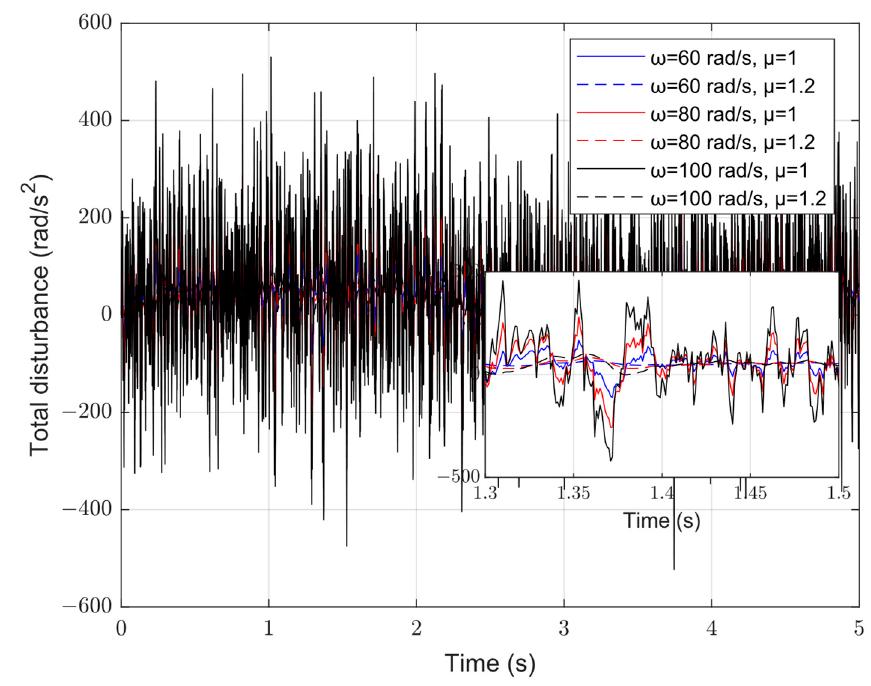
Figure 11. Estimated Total Disturbance with Measurement Noise.